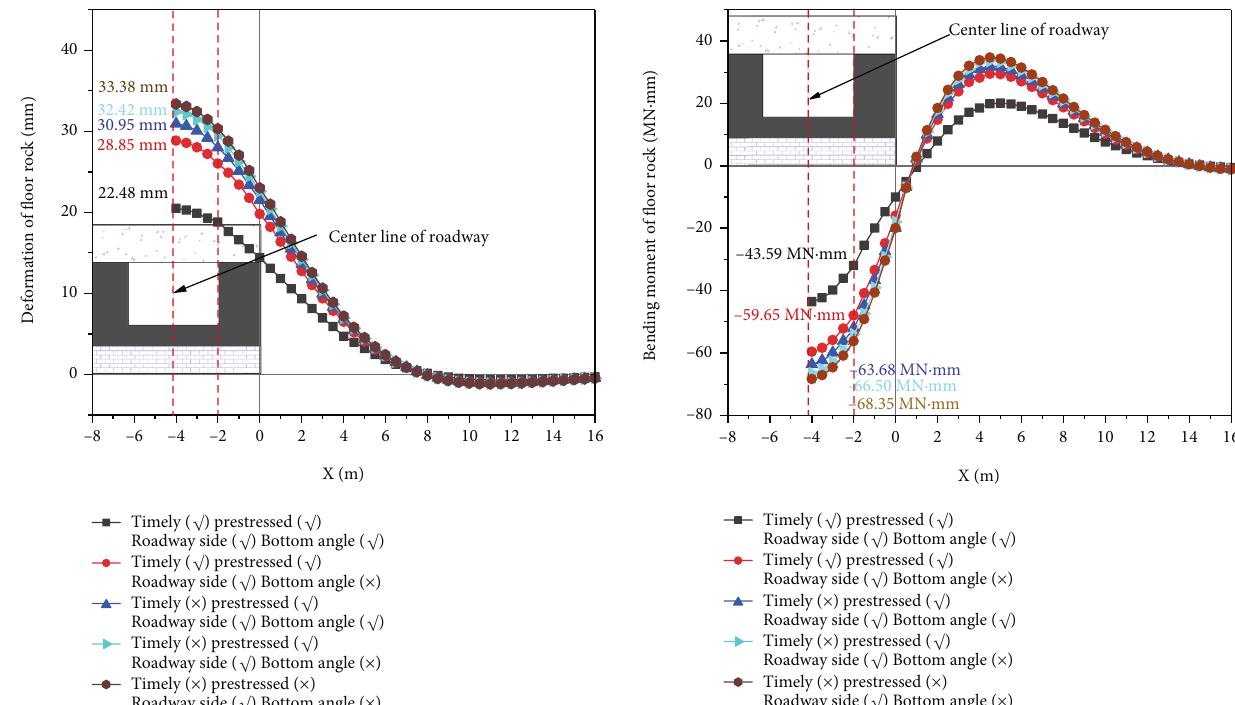
Figure 6: Deformation and bending moment of the fl oor rock under di ff erent support strategies.